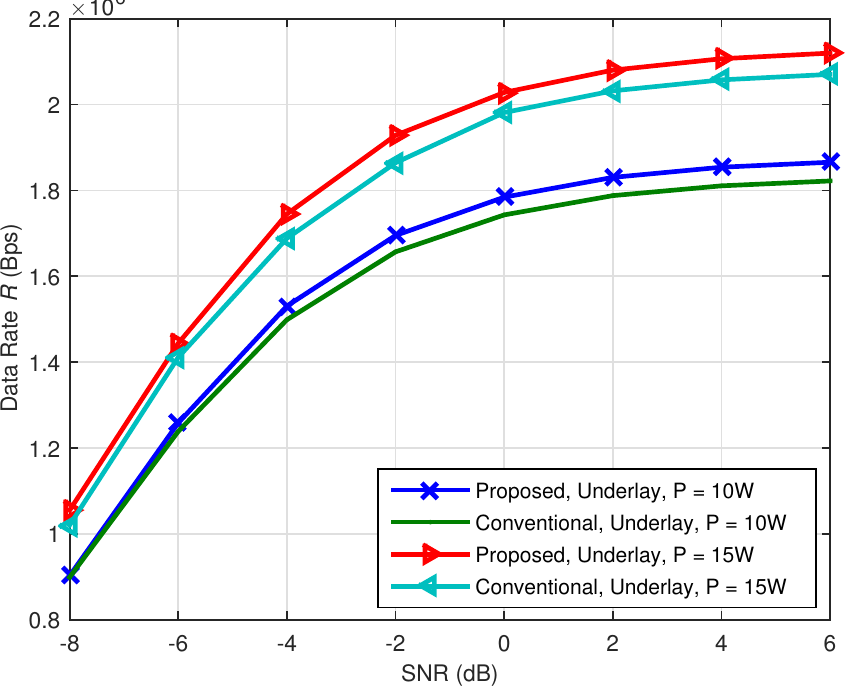
Figure 8. Comparison of the received SNR versus data rate curves between the proposed and conventional methods for underlay